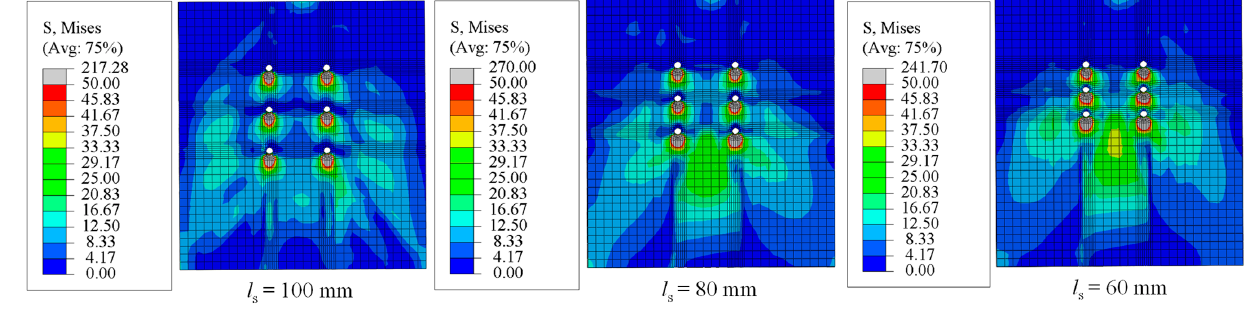
Figure 8. Distribution of von Mises stress on the PC slab.